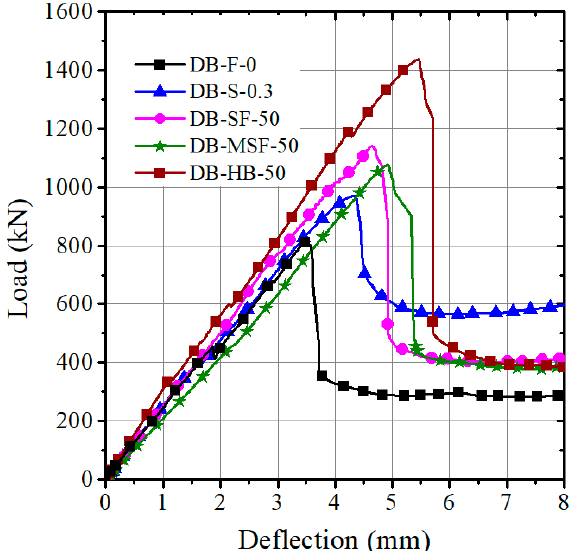
Figure 8. Normalized load-deflection behavior of all the specimens.